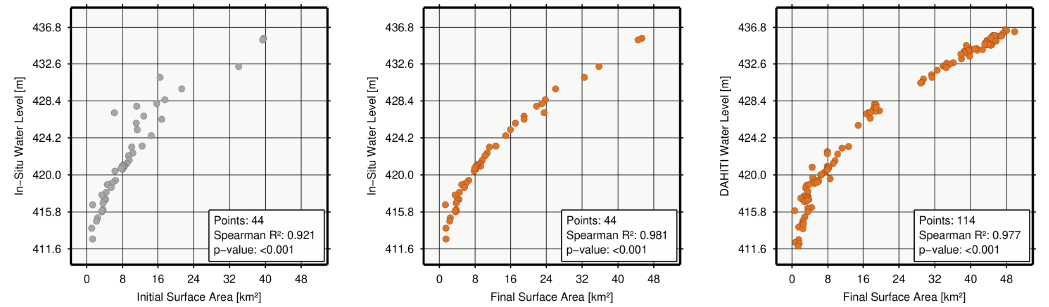
Figure 17. Validation of surface area time series for Poço da Cruz Lake using water levels from in situ stations and satellite altimetry. The improvement of our new approach is shown by comparing initial surface areas with data gaps ( left ) and final filled surface areas ( middle , right